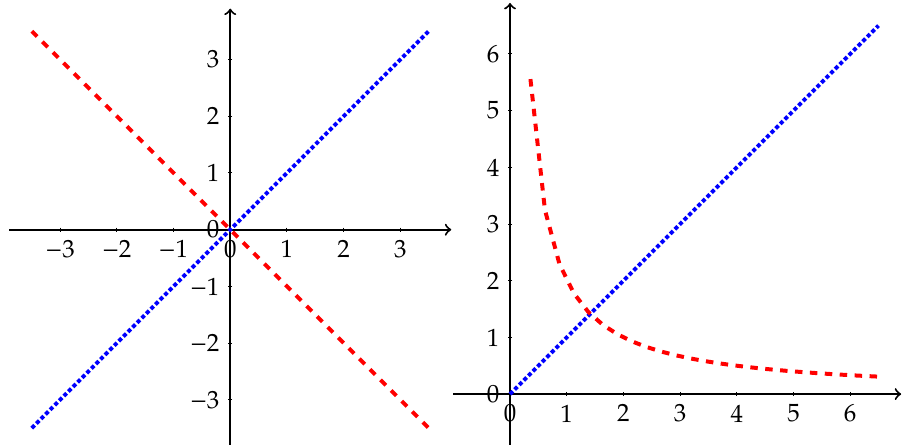
Figure A1. Support of bivariate distributions with maximum correlations (positive in blue and negative in red): model on R 2 (left) and also finite support; model on T + without finite